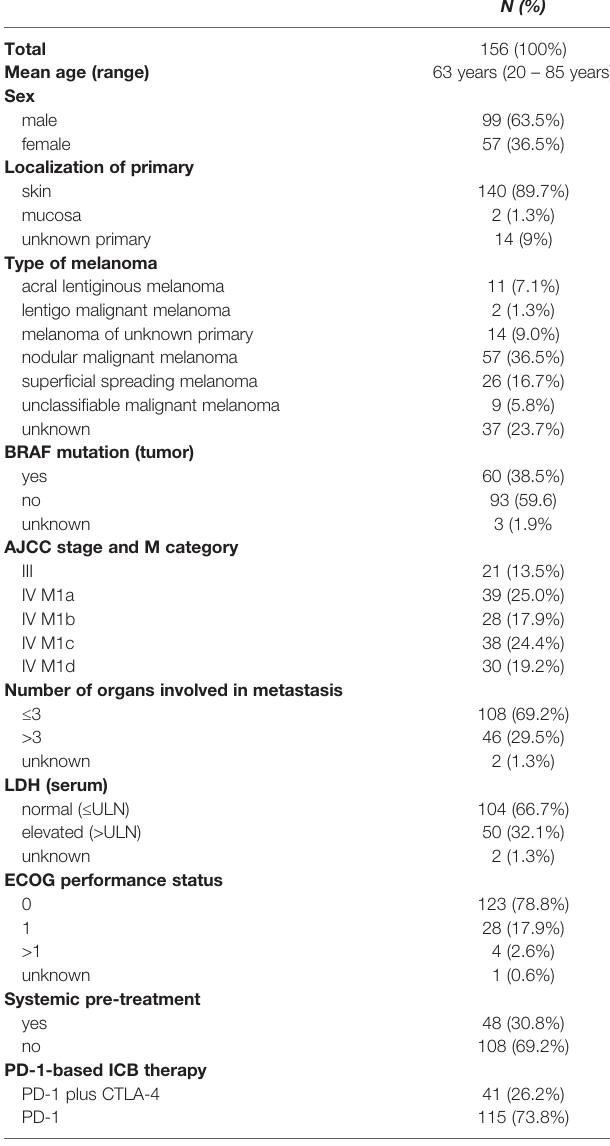
TABLE 1 | Patient